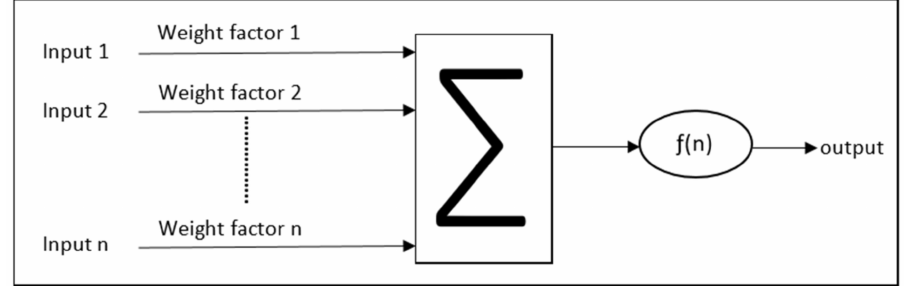
Figure 2. McCulloch–Pitts neuron.